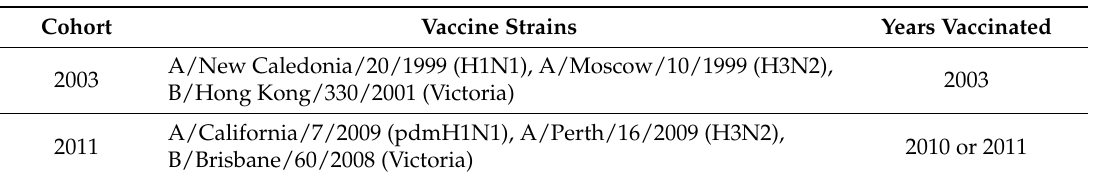
Table 1. Experimental Cohorts, Virus Vaccine Strains and Years Vaccinated. See Materials and Methods section for more